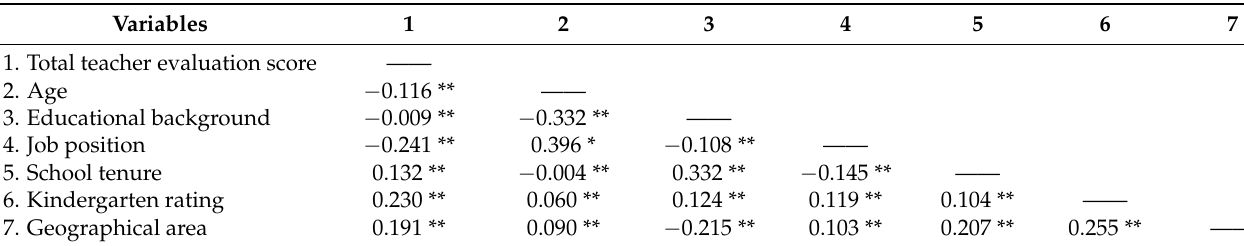
Table 4. Correlation matrix.